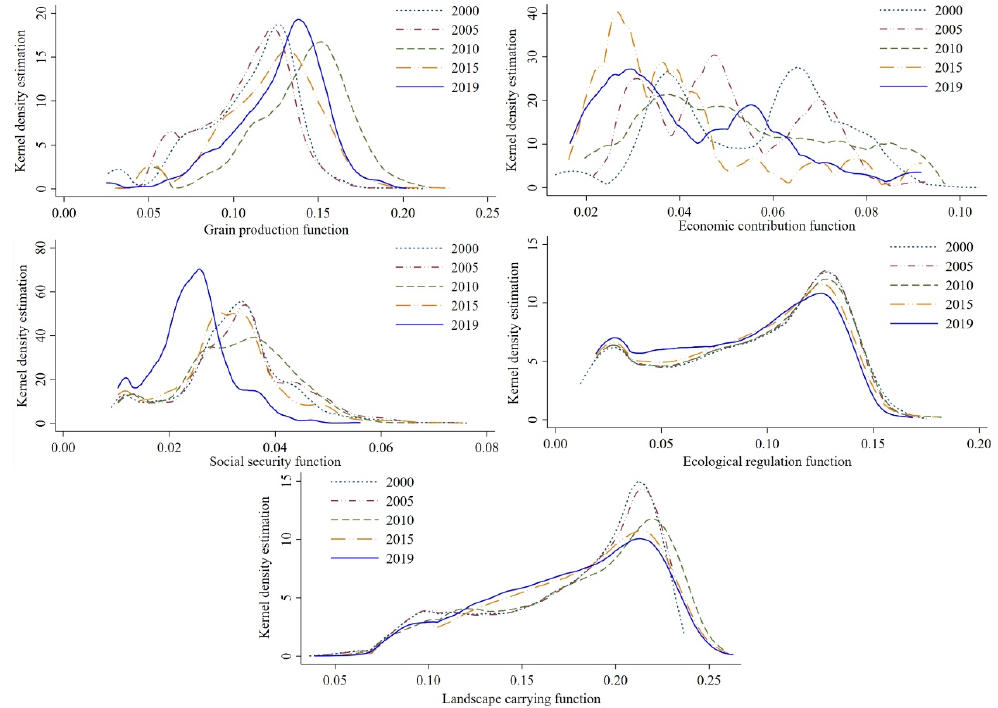
Figure 4. Kernel density curve of various functions of the cultivated land system.